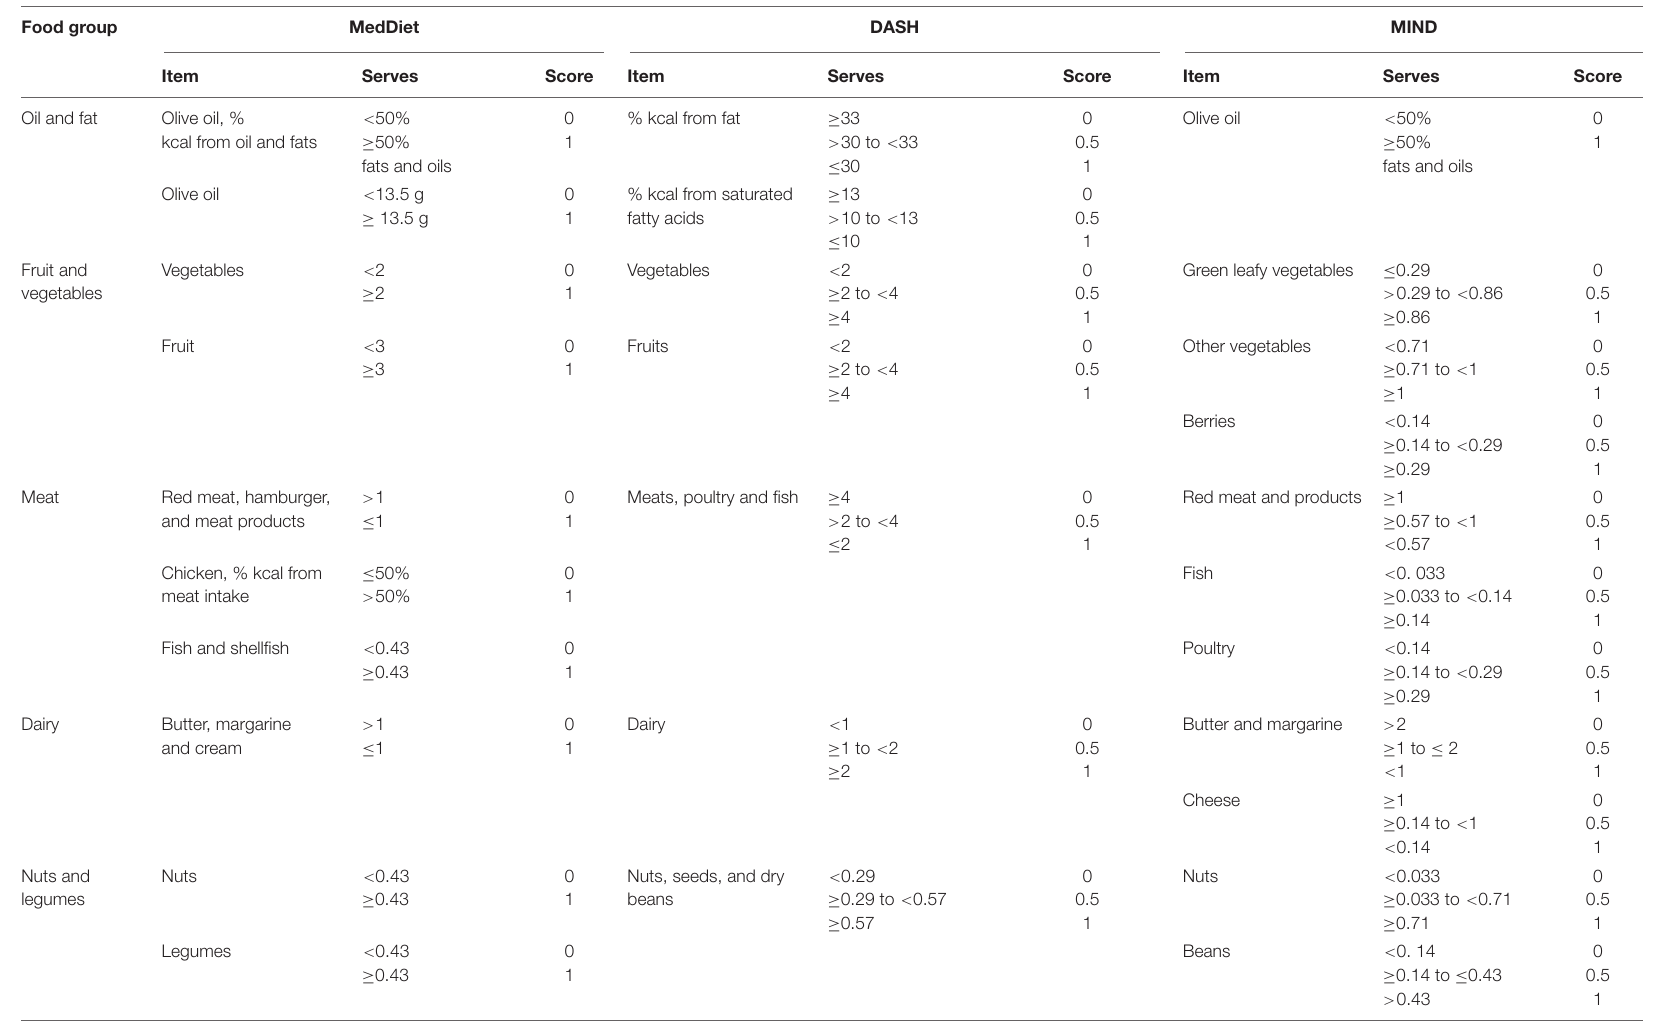
TABLE 1 | Dietary scores for MedDiet, DASH and MIND. Food group